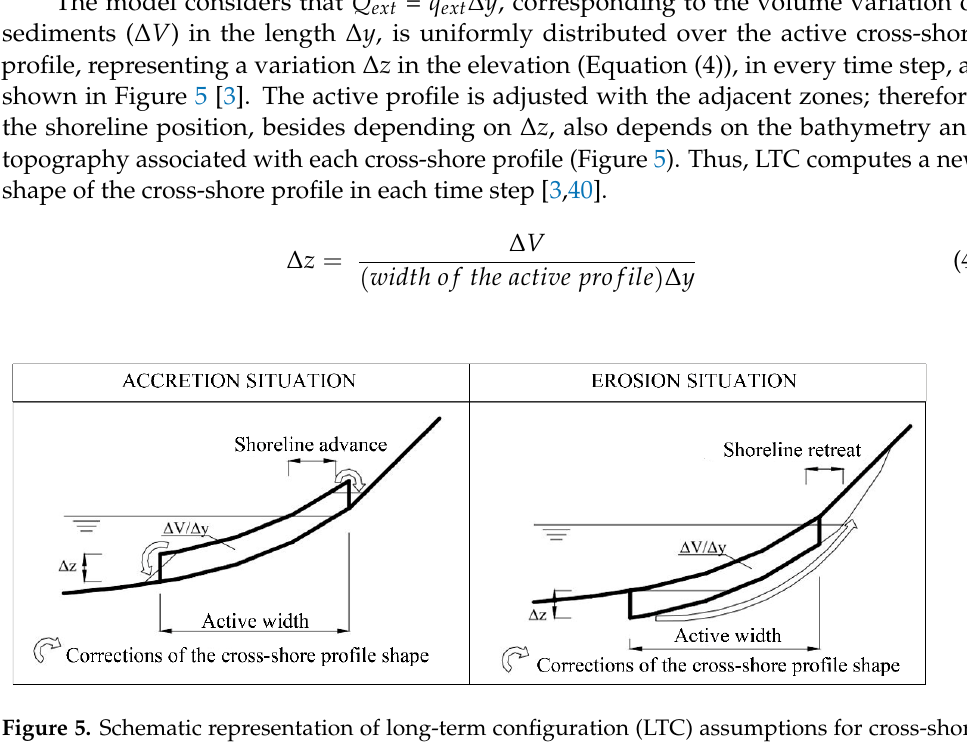
Figure 5. Schematic representation of long-term configuration (LTC) assumptions for cross-shore profiles updated during computational calculations (adapted from [3]).